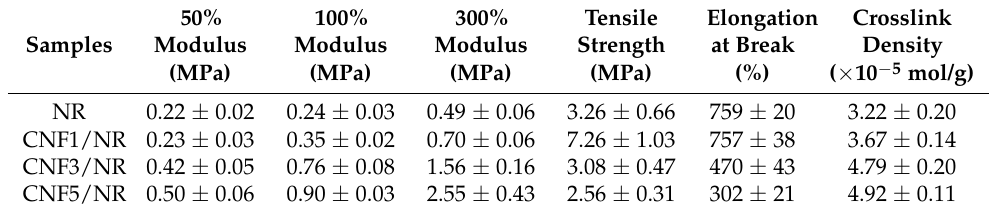
Table 3. Summary of the mechanical properties of the NR and the CNF/NR